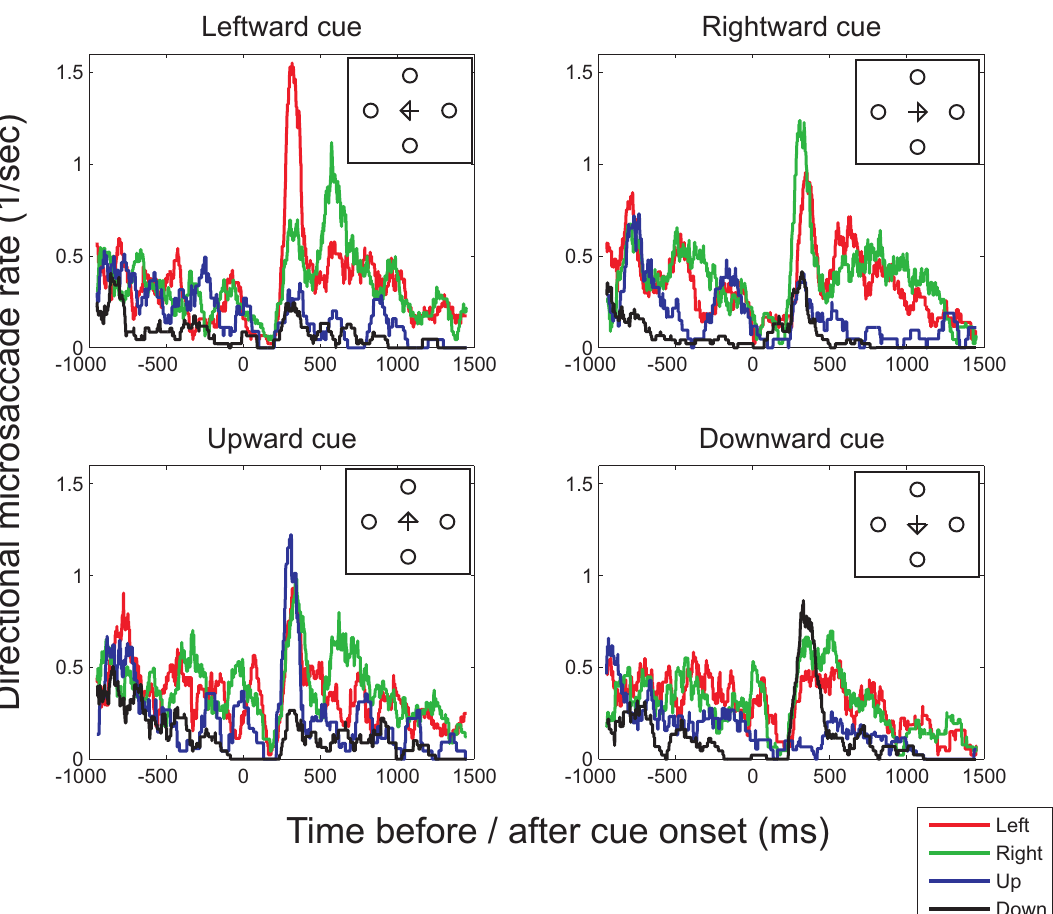
Figure 7 . Binocular microsaccade rates in each of the four principal directions as a function of the time before (negative values on the horizontal axis) or after cue onset (positive values) in the condition in which the target could appear in one of the four locations (illustrated in the small insets). Histograms were computed using a moving window of 100ms and time-steps of 1ms. Response